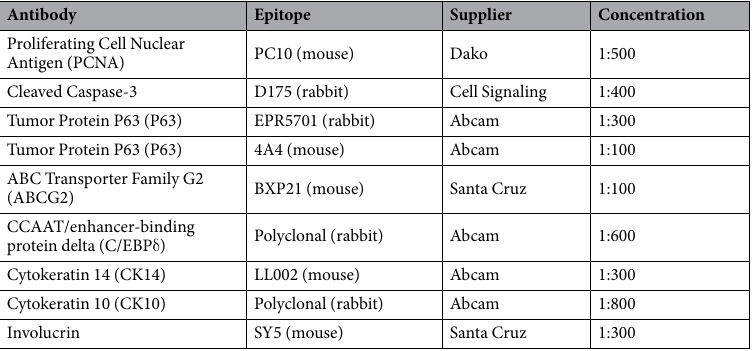
Table 2. Antibodies Used in